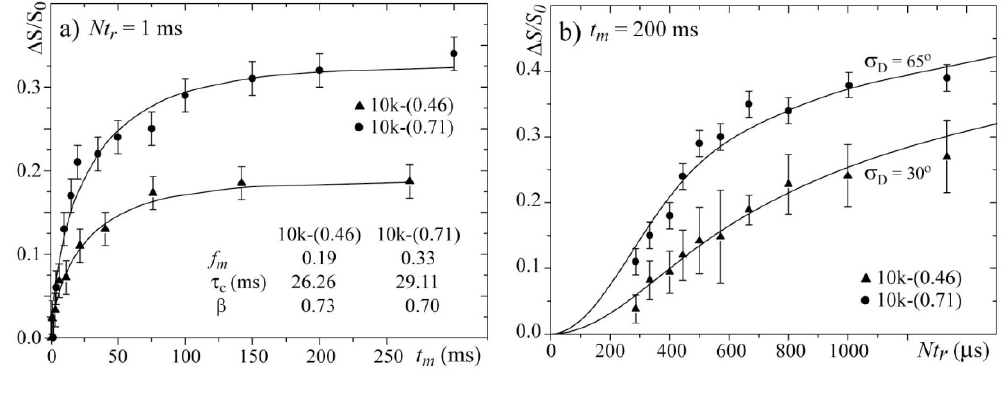
Figure 8. ( a ) Mixing time t normalized intensities for the 10k-(0.71) sample at T = 20 °C and the 10k-(0.46) sample at T = 100